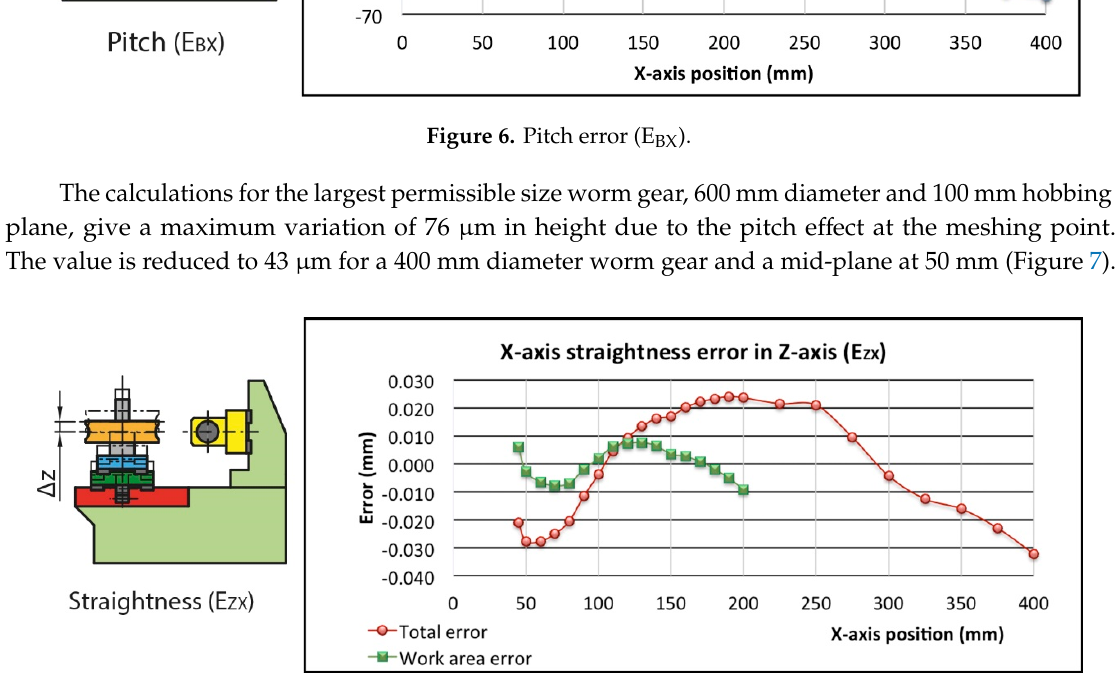
Figure 8. Non-compensated errors (Y-axis) due to movement along the X-axis.